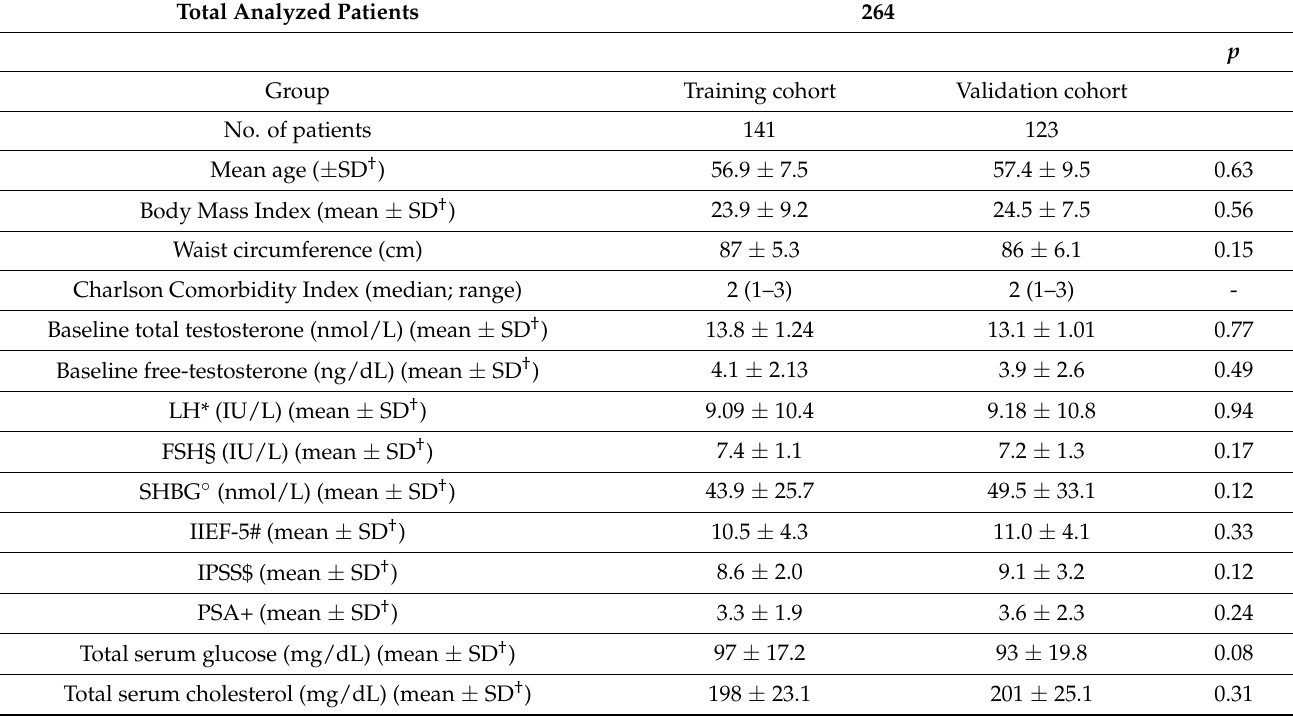
Table 1. Patient clinical and laboratory characteristics at enrolment time, stratified by study phase. Total Analyzed